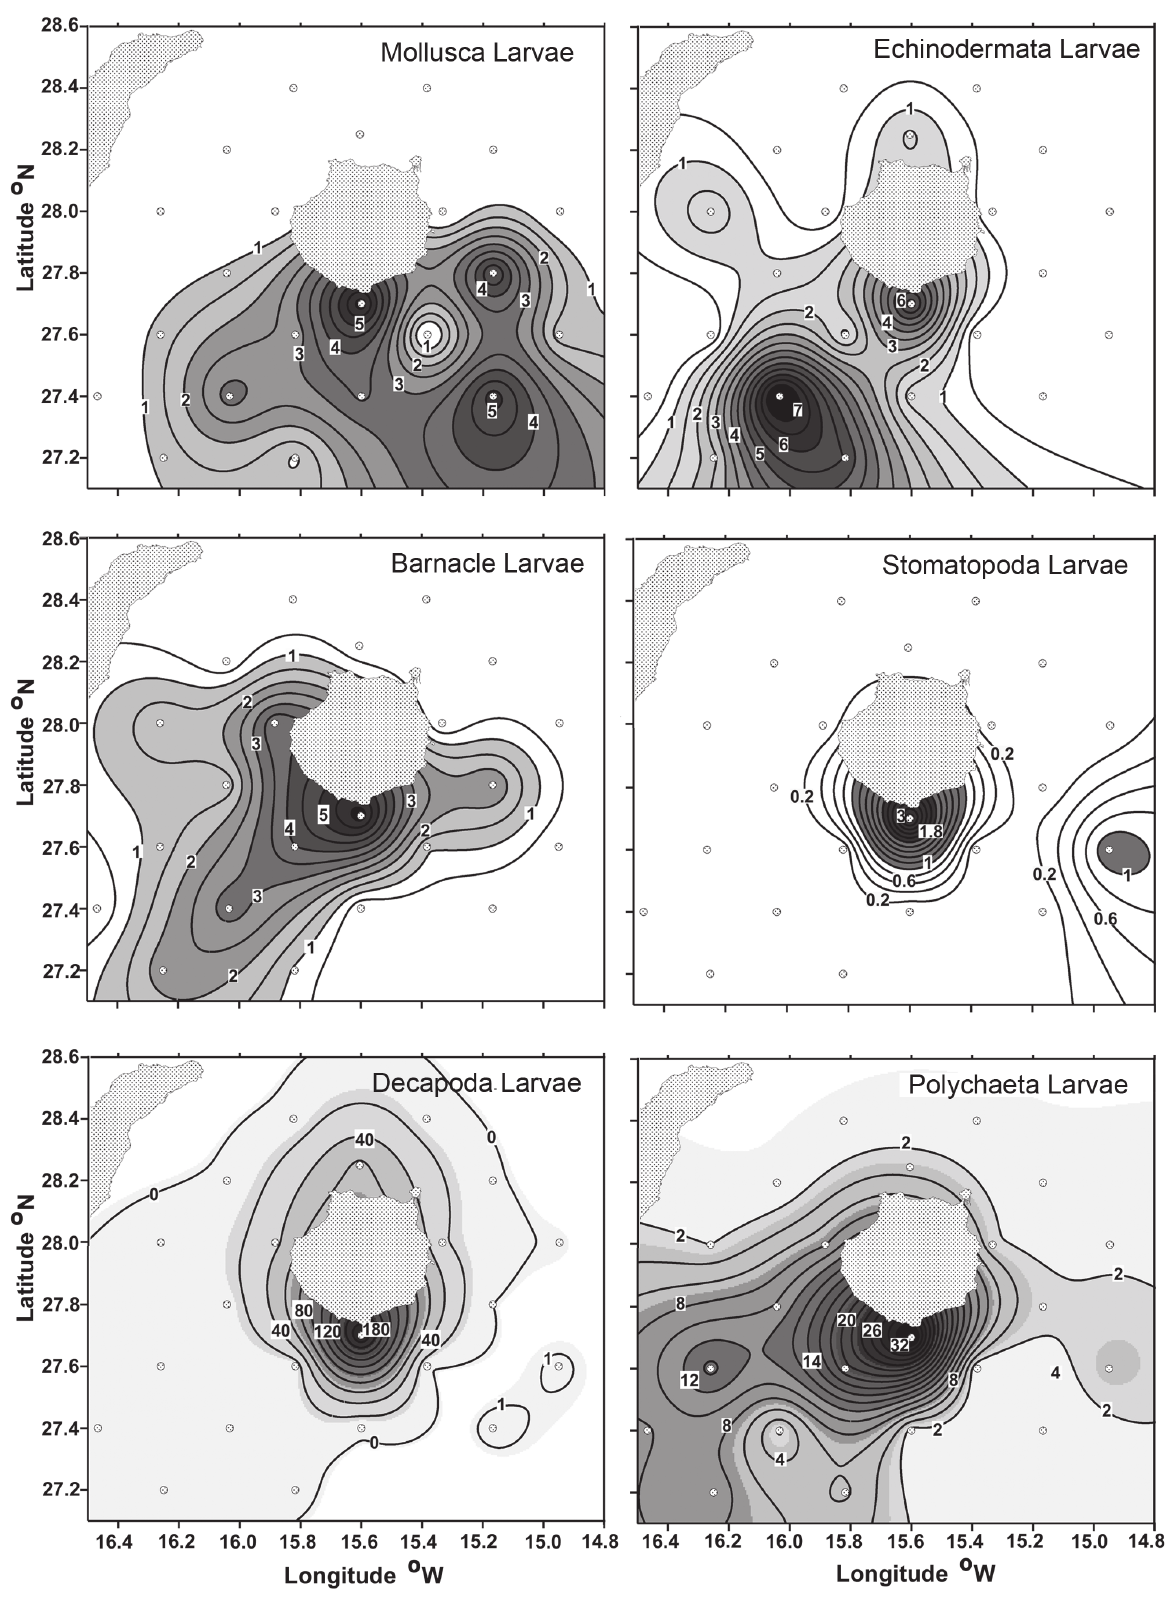
Fig . 3. – Horizontal distributions of larval abundance (larvae/100 m 3 ) for the invertebrate groups. circles refer to the sampled